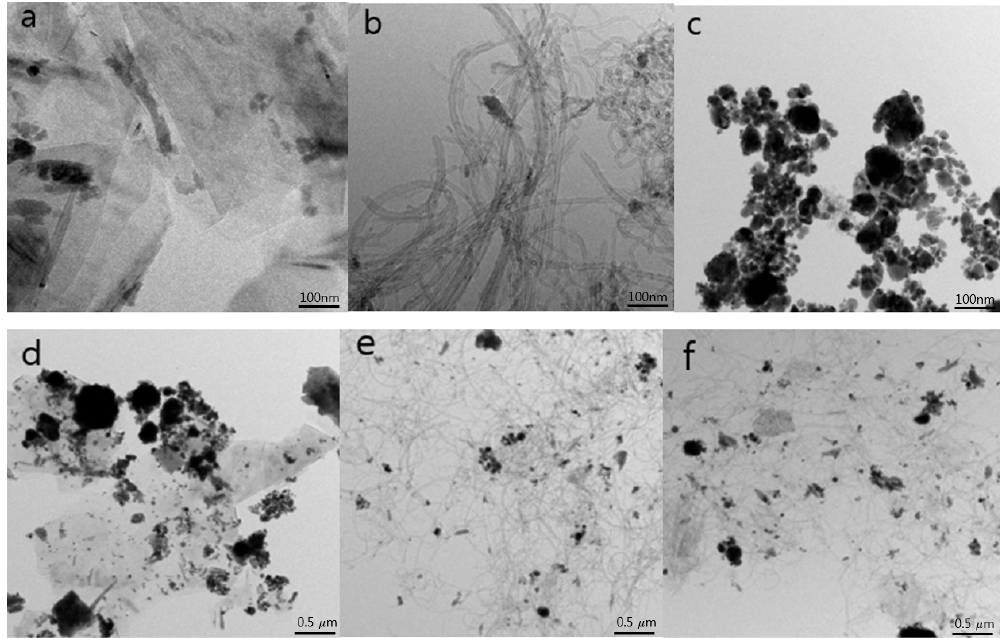
Figure 4. Micrographs of our samples: ( a ) graphene (GN); ( b ) multi-walled C nanotubes (MWCNTs); ( c ) Ag nanoparticles (AgNPs); ( d ) GN-AgNPs; ( e ) MWCNTs-AgNPs; ( f ) GN-MWCNTs-AgNPs. The AgNPs in ( c ) were produced in pure water using the PWE method.